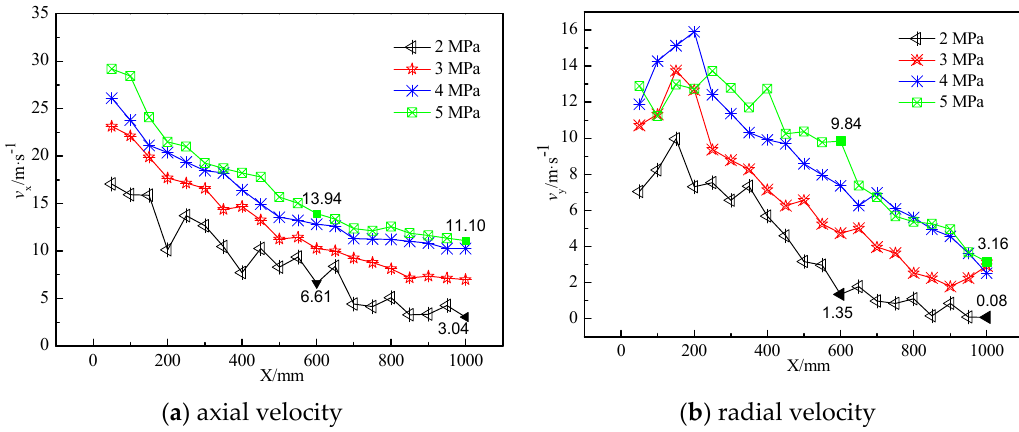
Figure 15. Axial and radial velocity along the axial direction under different pressures.